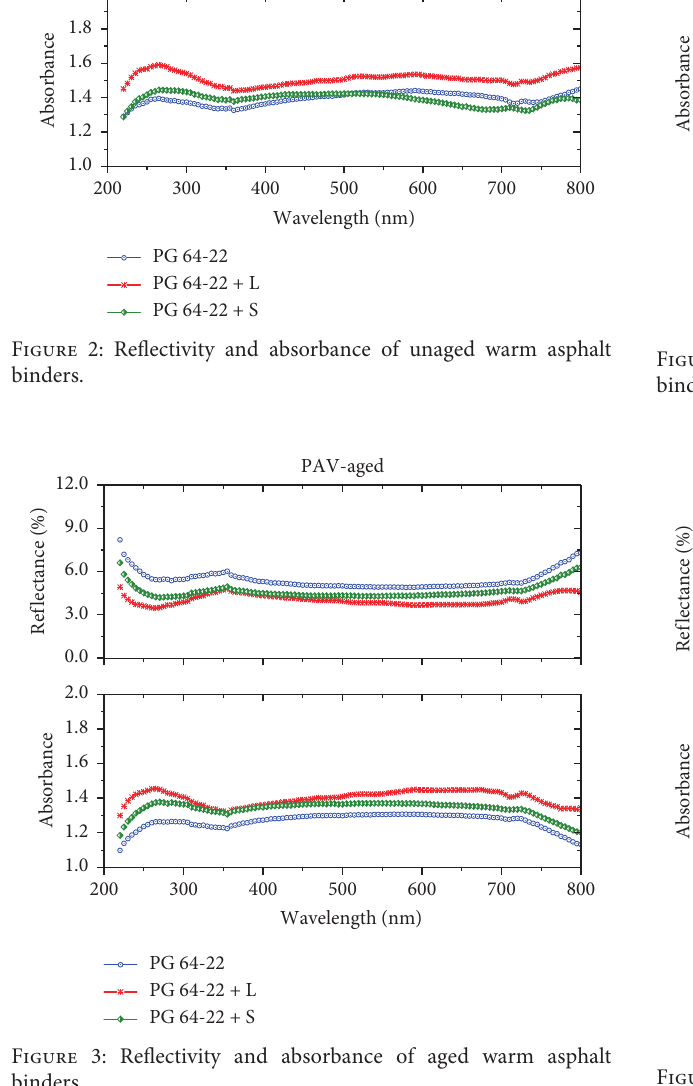
Figure 5: Reflectivity and absorbance of aged warm CRM